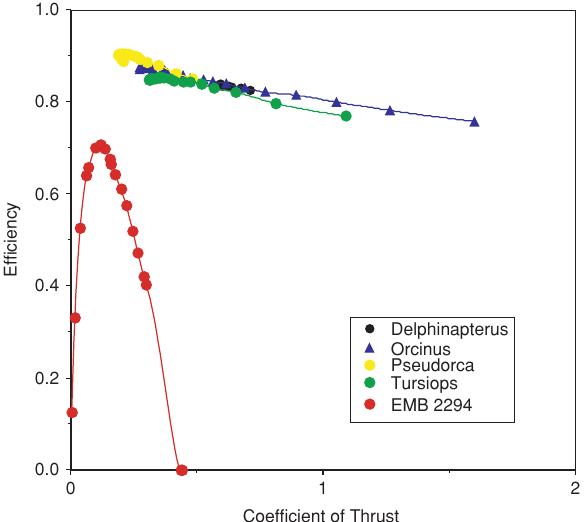
Figure 3 Comparison of relationships of propulsive efficiency and thrust coefficient for four species of small whales and a typical marine propeller. Data for the whales was obtained from Fish (1998) and data for the propeller was from Saunders